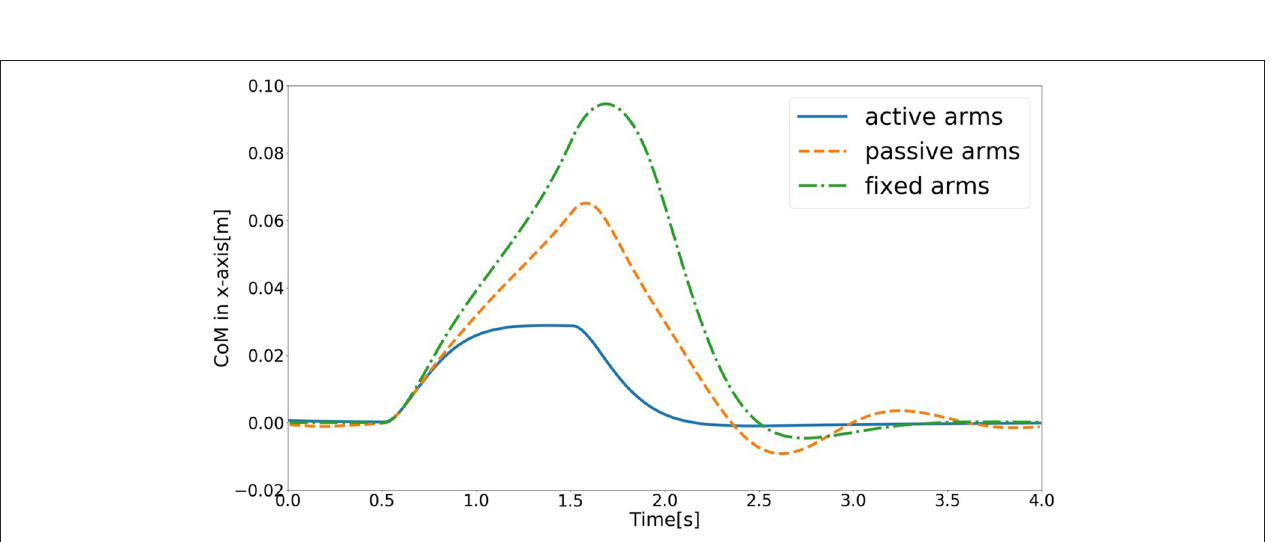
FIGURE 5 | Evolution of center of mass of the model in the x-axis direction for the three different arm states (active arms, passive arms, and fixed arms) for a disturbing force of 70 [ N ].